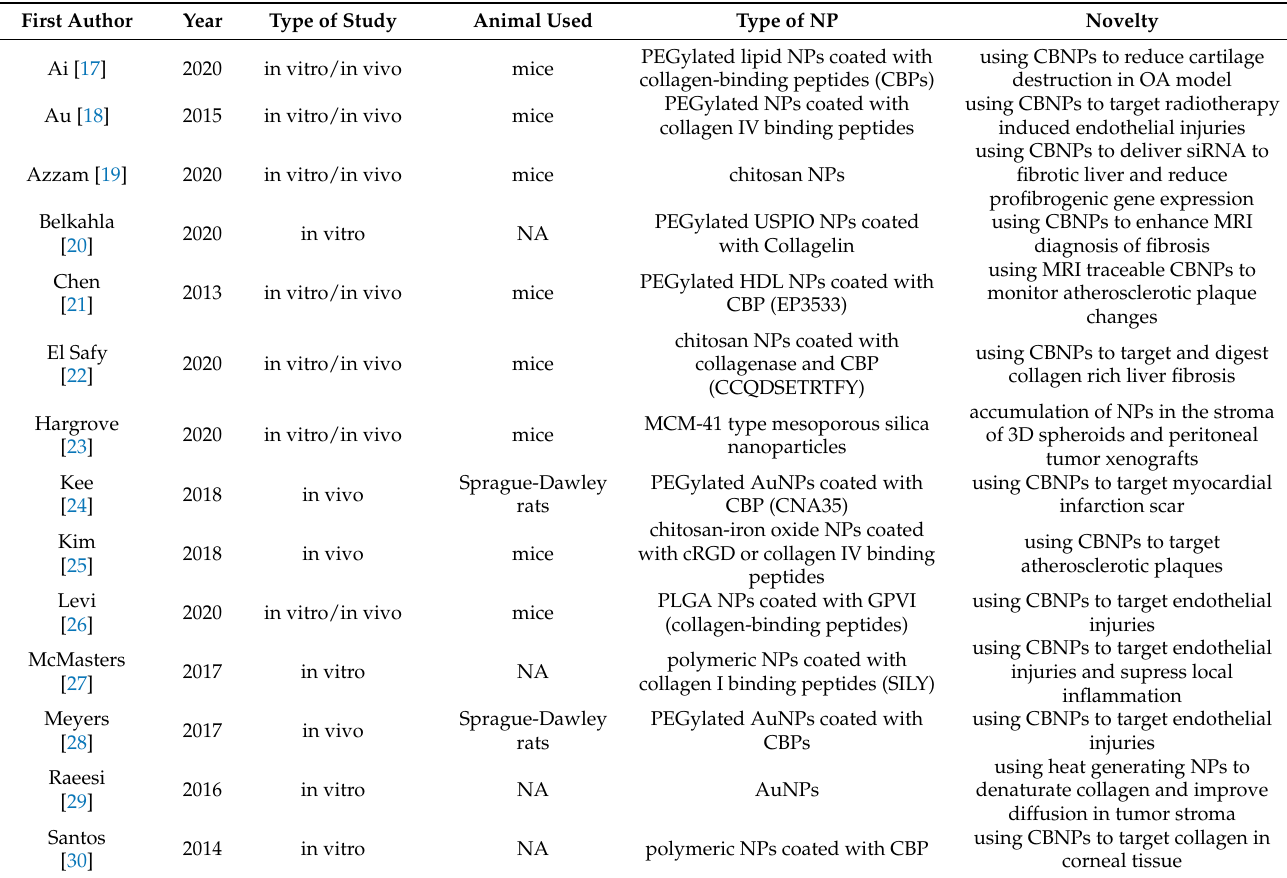
Table 1. Overview of the included